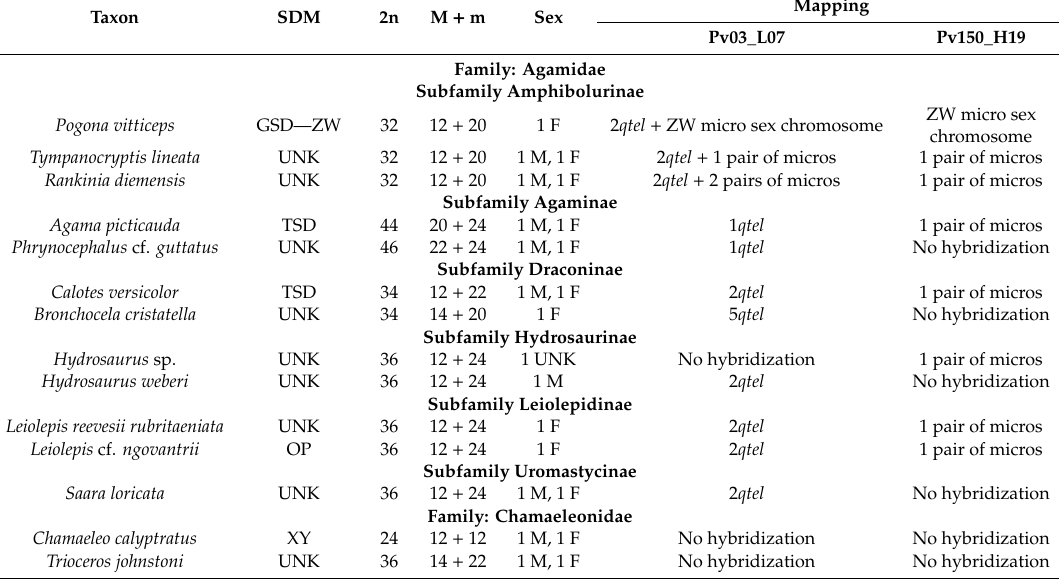
Table 1. Results of the bacterial artificial chromosome (BAC) clone fluorescence in situ hybridization (FISH) experiments. SDM = sex determination mechanism, 2n = diploid chromosome number, M + m = number of macrochromosomes and microchromosomes, GSD = genotypic sex determination, TSD = temperature-dependent sex determination, UNK = unknown, OP = unisexuality with obligatory parthenogenesis, qtel—telomeric region of the large arm of a